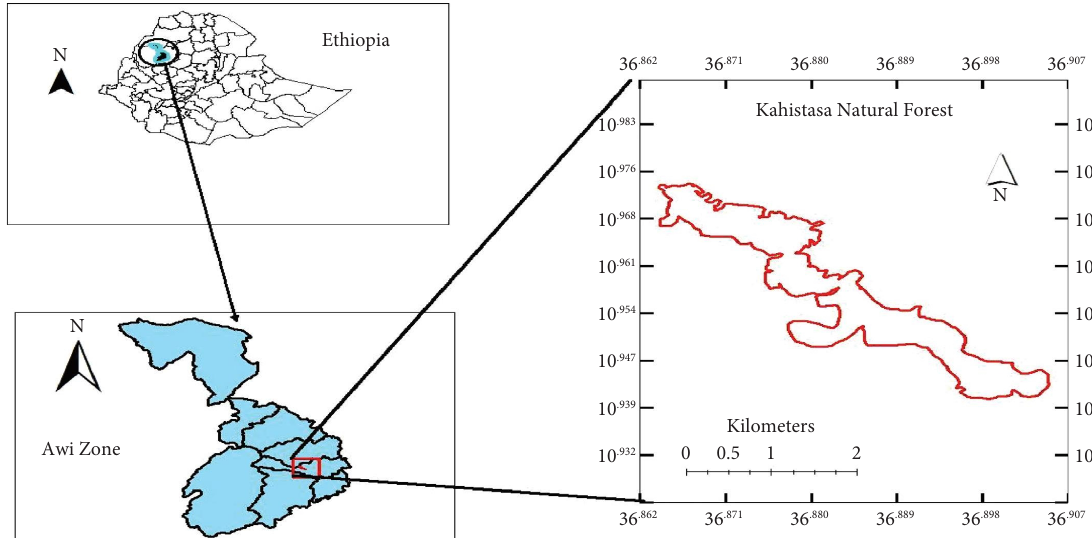
Figure 1: Map of the study area.